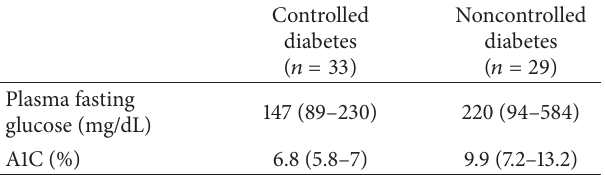
Table 2: A1C and plasma fasting glucose levels in diabetic